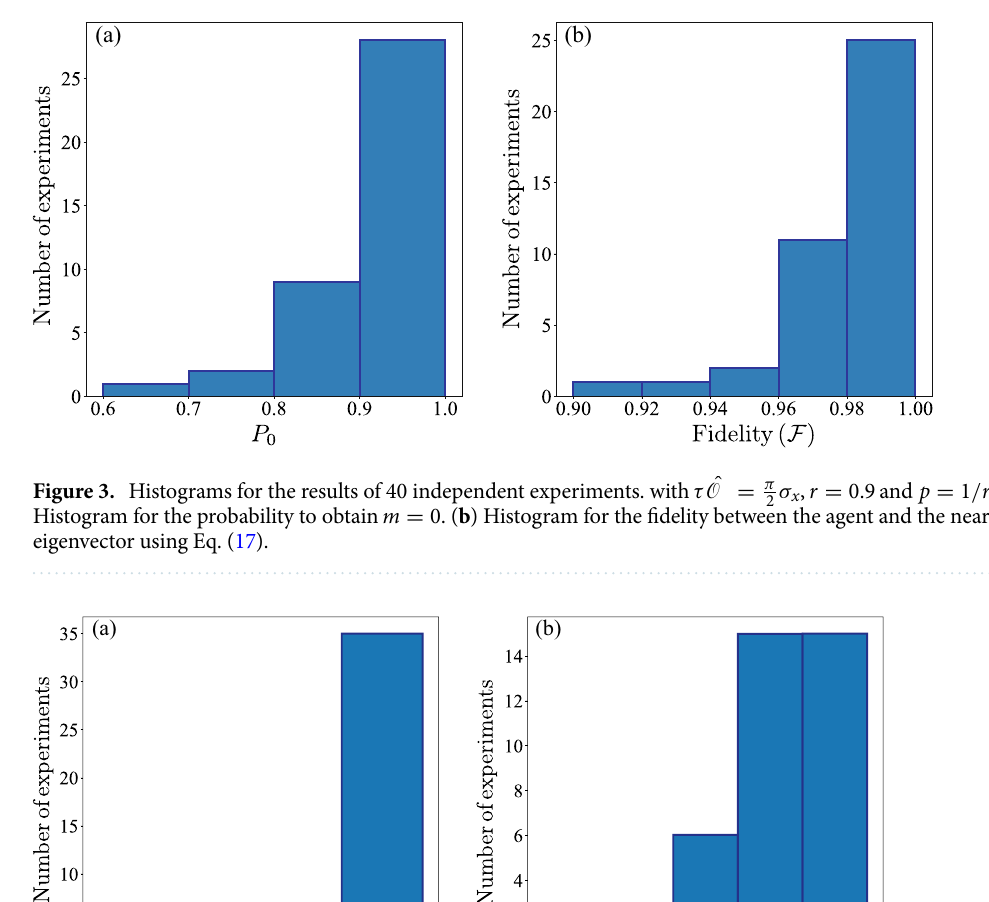
ˆ O = π σ x , r = 0.9 and p = 1.5 / r . 4